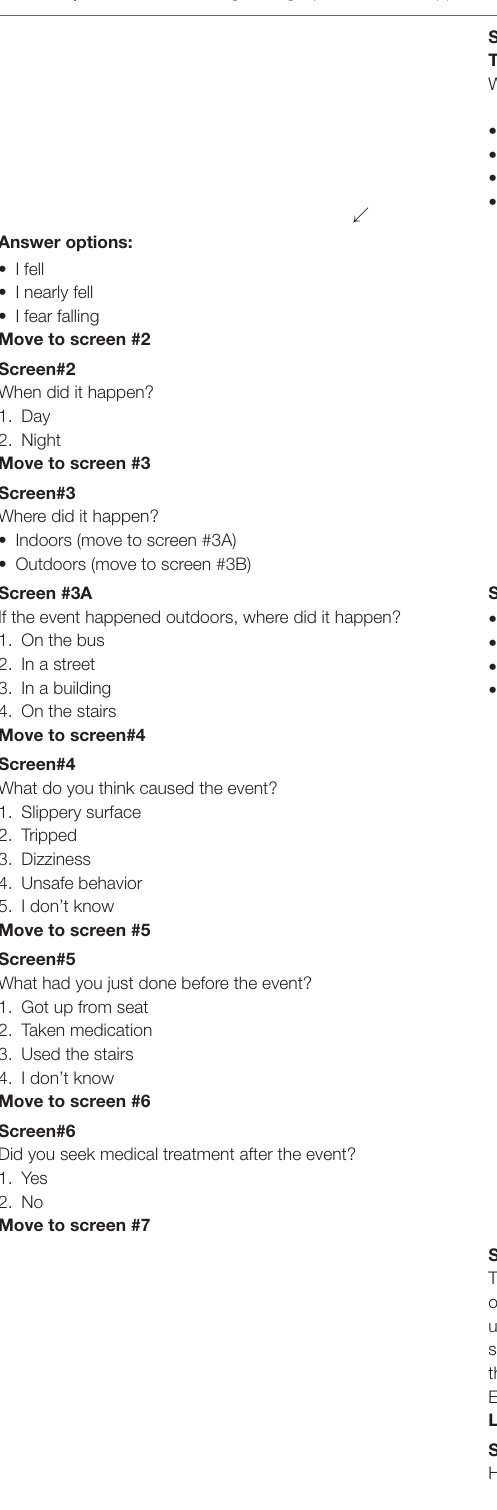
TABLE 2 | Flow chart illustrating the logic process of the App.